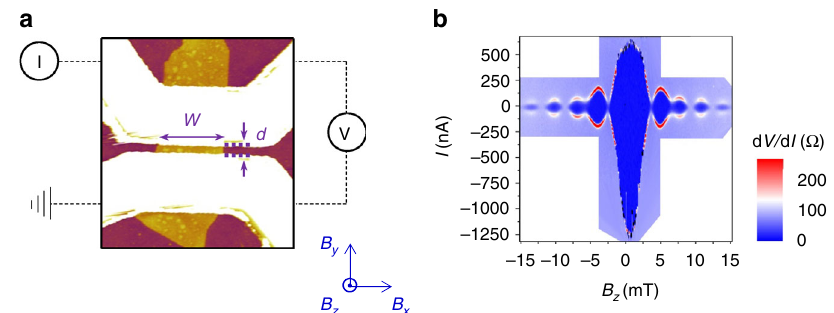
Fig. 1 Measurement con fi guration and Device 1 Fraunhofer pattern. a AFM image of the S-TI-S Josephson junction: superconducting leads (white) on a Bi 2 Se 3 fl ake (yellow) exfoliated onto a substrate (red). Measurement scheme and magnetic fi eld con fi gurations are also shown. b Conventional Fraunhofer pattern for device 1 ( t ~ 9 nm, d ~ 140 nm, and W ~ 920 nm). The conventional pattern has a principal peak at B z = 0